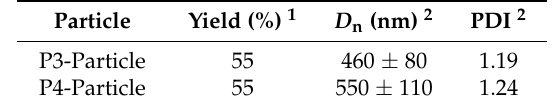
Table 2. Preparation of Mal-decorated polymer particles.